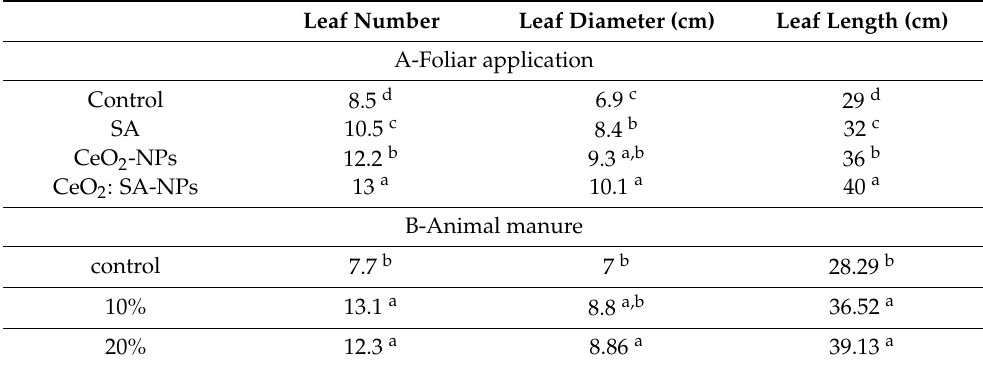
Table 3. The effects of salicylic acid (SA), CeO 2 -NPs, and CeO 2 : SA-NPs foliar treatments and 10% and 20% of soil-based animal manure use on leaves’ number and diameter, and leaf length of Aloe vera L. plants.